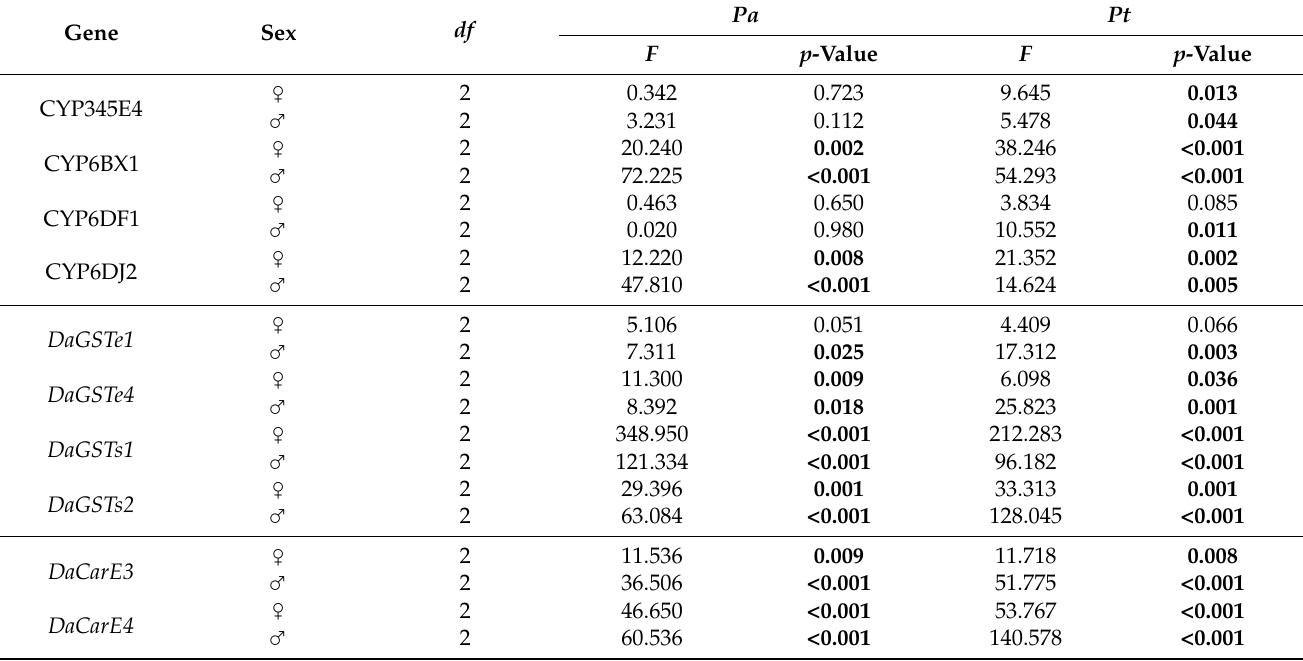
Figure 2. Realtime qPCR analysis of the relative expression of four P450 genes (mean ± SE) in D. armandi after being fed on two different diets for 24 and 48 h. Values > 1 on the logarithmic y-axis indicate upregulation. Gene expression was normalized with respect to the geometrical mean of β -actin and CYP4G55. The different letters indicate statistically significant differences in gene expression among different times for the same type of diet compared with Tukey’s HSD ( p < 0.05). The 2 − ∆∆ Ct and SE values were log 2 transformed for plotting. Table 2. One-way ANOVA and Tukey test results regarding the expression of D . armandi detoxifying enzyme genes after being fed seminatural